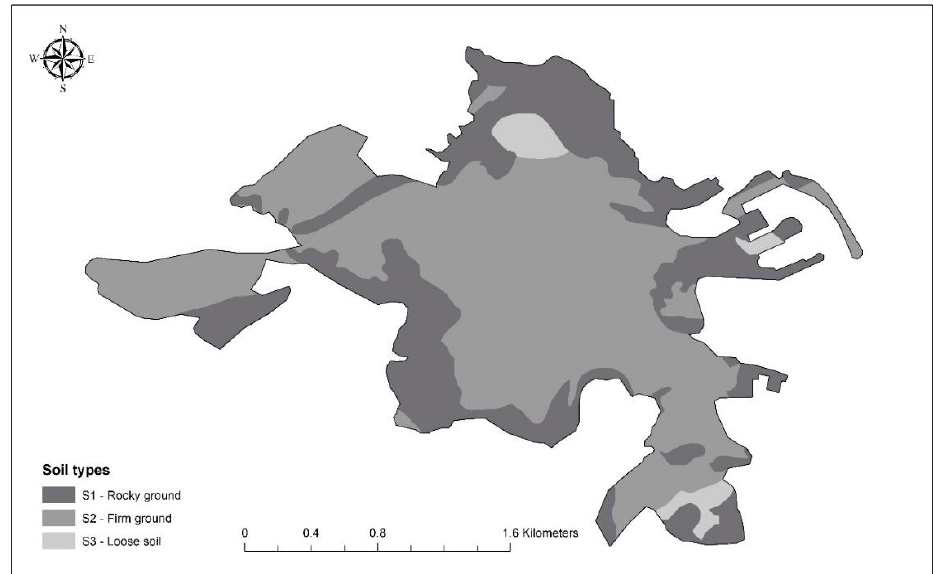
Figure 4. Distribution of soil types in the city of Al Hoceima [37].